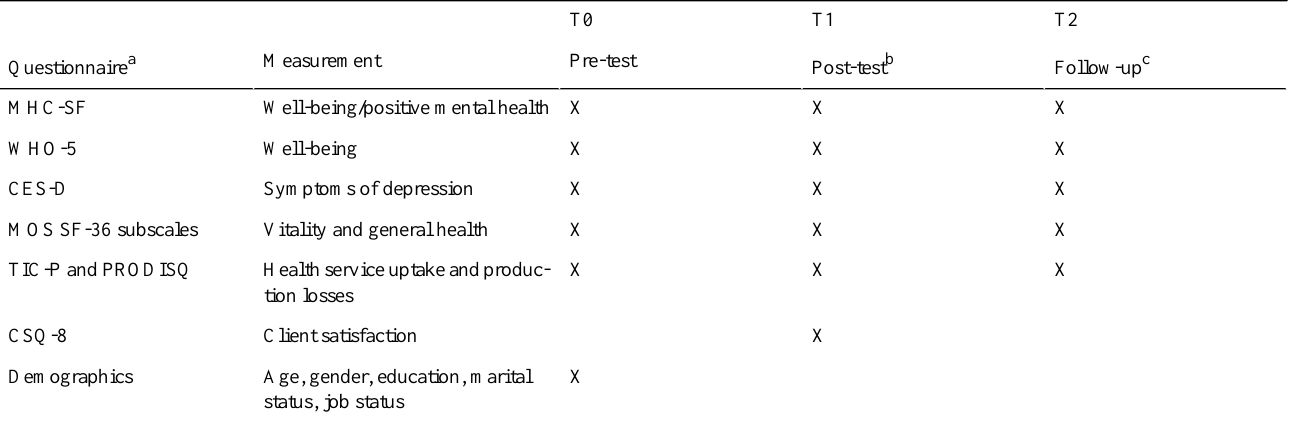
Table 1. Questionnaires and assessment